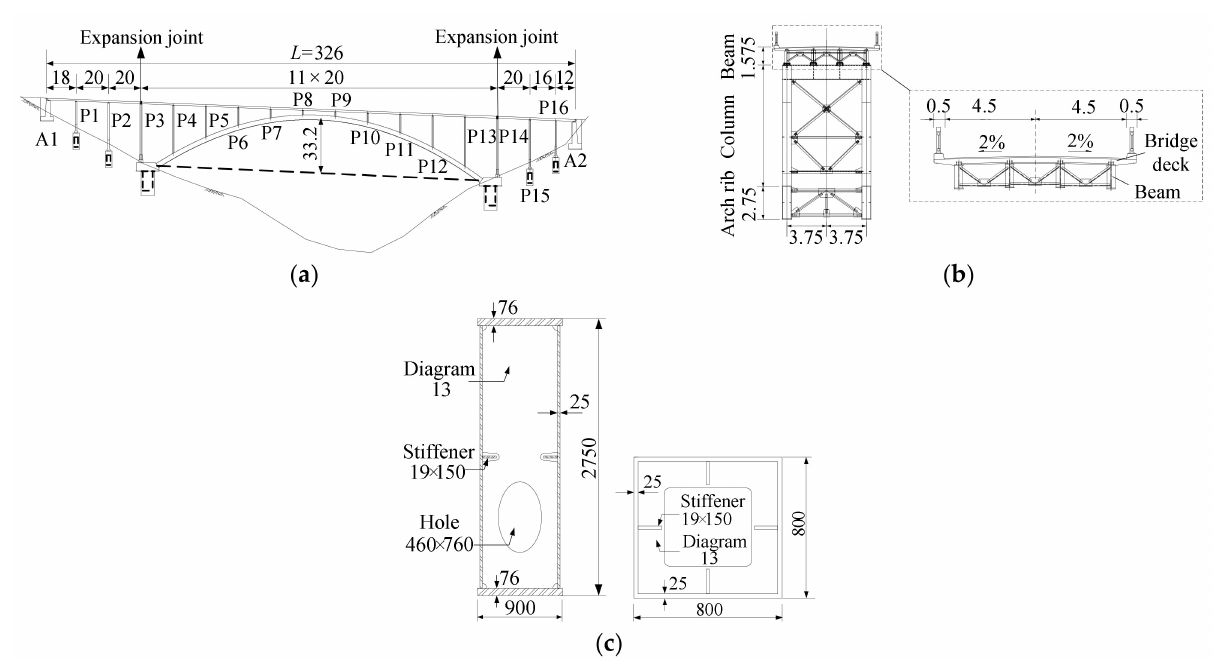
Figure 8. Structural design of the bridge: ( a ) elevation of the bridge (unit: m); ( b ) transverse view of the bridge (unit: m); ( c ) cross-sections of the arch rib and column (unit: